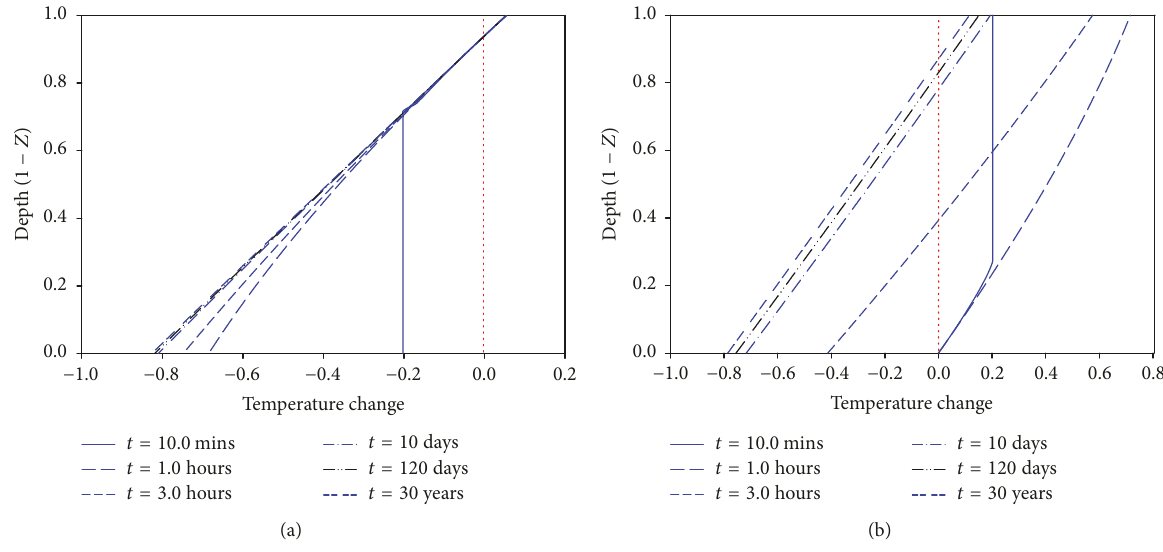
Figure 4: Temperature change profiles along the (a) injection and (b) production wells when 𝑄 = 0.05 m 3 /s, L 1 = 3500 m, and L 2 = 6000m.